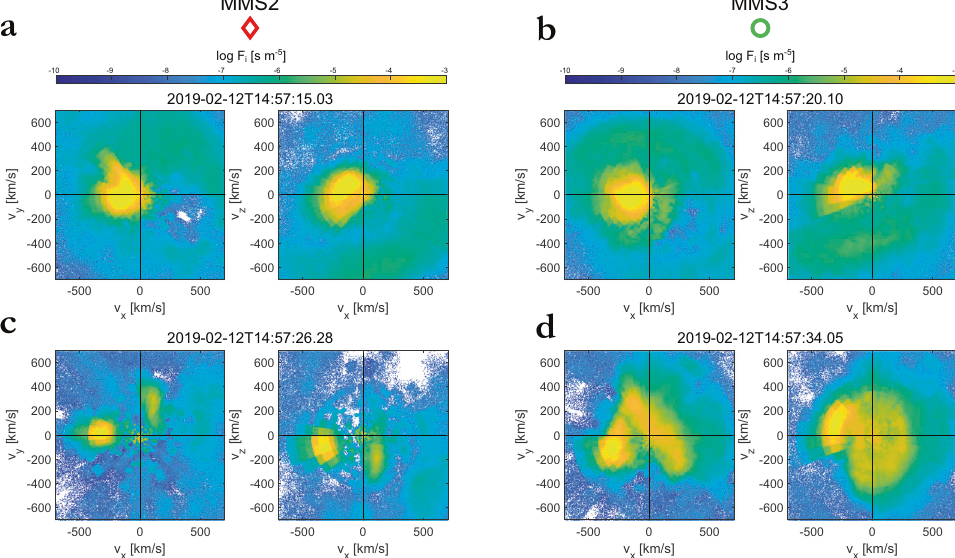
Fig. 5 2D velocity distribution functions (VDFs) for each observed structure. Reduced 2D VDFs for a the compressive magnetic structure/shock (red shaded region 1 of Figs. 2a and 4a) as observed by the outermost spacecraft, Magnetosphere Multiscale (MMS) 2. b The same structure as observed by the innermost spacecraft, MMS3. c Upstream waves (blue shaded region 1 of Figs. 2a and 4a) as observed by the outermost spacecraft, MMS2. d Magnetosheath jet (purple shaded region 1 of Figs. 3b and 6b, c) as observed by the innermost spacecraft, MMS3. All projections are in Geocentric Solar Ecliptic (GSE)